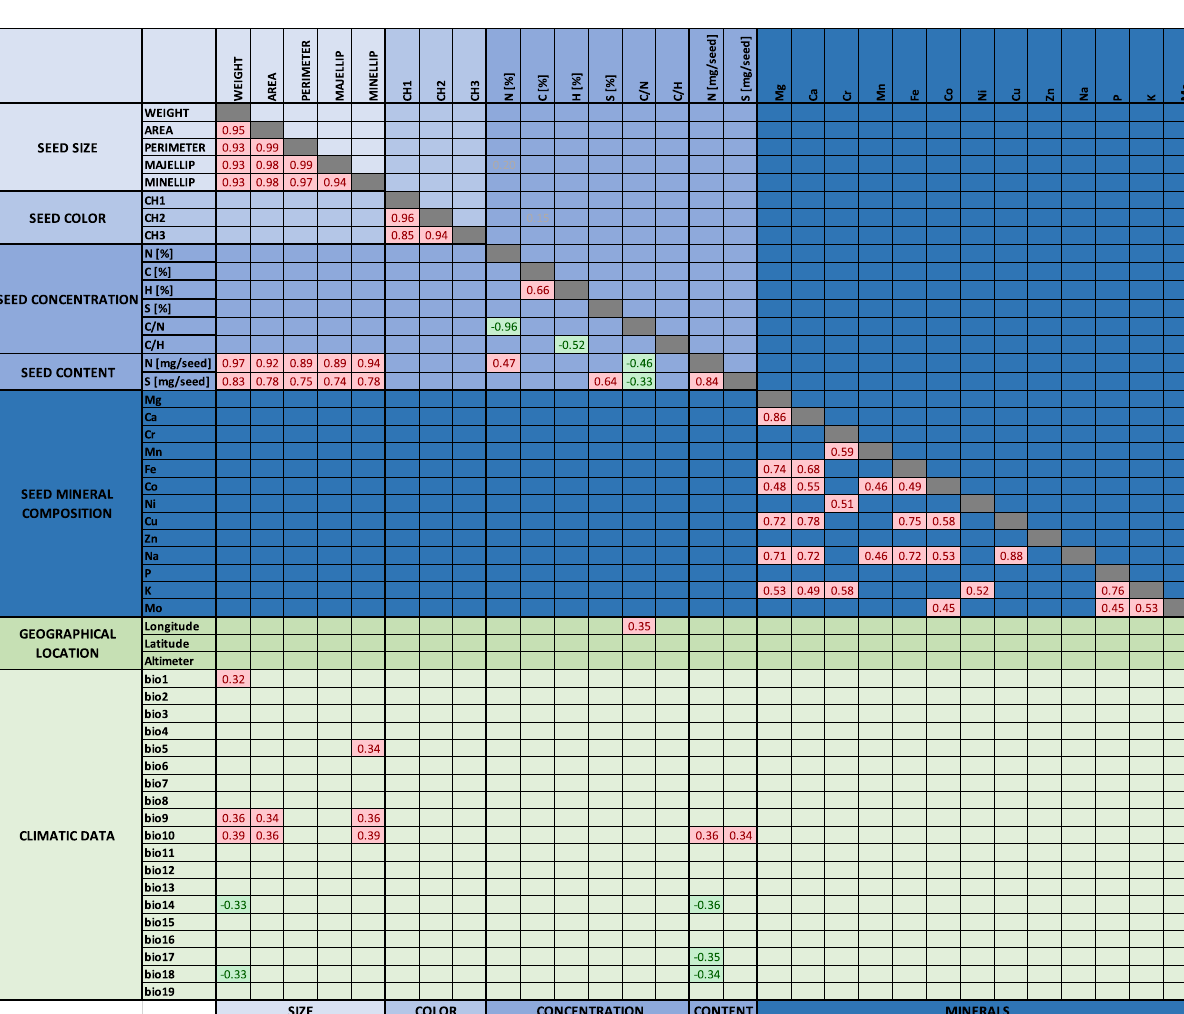
corresponding to observed results below the theoretical curve (i.e. deflated curve), which suggested that this model was not appropriate for this association study. Regarding the Manhattan plots obtained from different